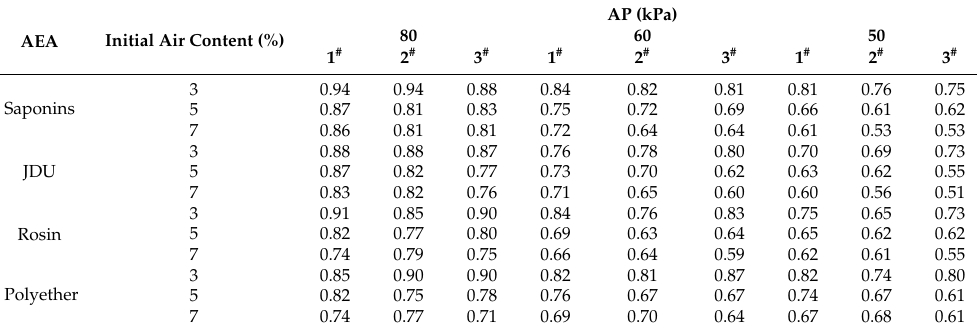
Table 3. Relative air content of concrete after normalized treatment.